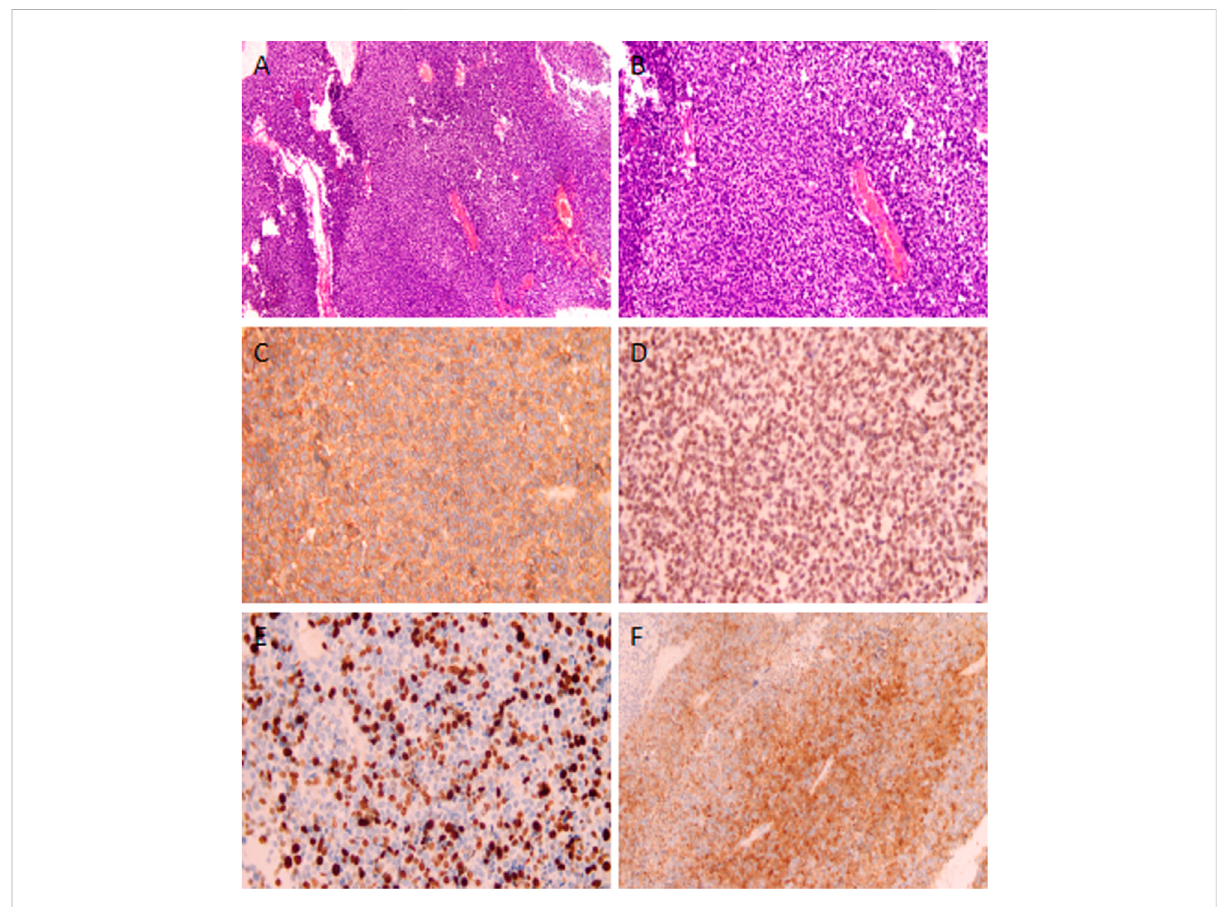
FIGURE 2 (A,B) MicroscopicviewofthetumorofthecervixwithH&Estaining,revealingthattumorswerecomposedofamonotonouspopulationofsmall round cells. IHC staining was positive for (C) CD99, (D) FLI-1, (E) Ki-67, and (F) p16. Magni fi cation details: (A) ×100; (B) 200×; (C) 200×; (D) 400×; (E) 200×; and (F)